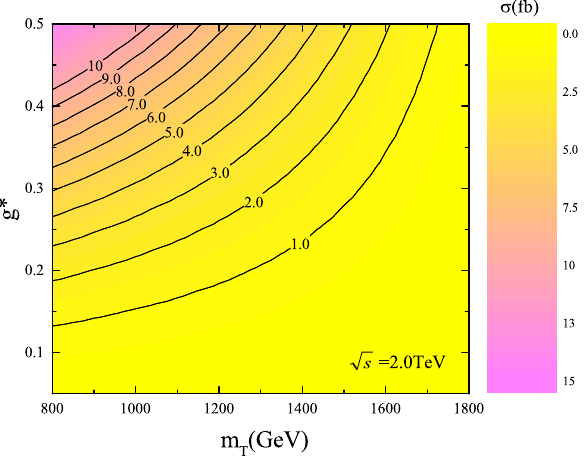
Fig. 3 The cross sections of the top partner on the g ∗ ∼ m T plane at √ s = 2 . 0 TeV